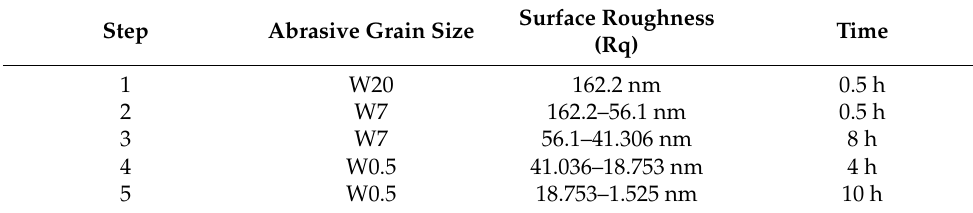
Figure 11. Surface morphology of initial surface, polished surface, and mirror surface: ( a ) Initial surface; ( b , c ) Polished surface; ( d ) Mirror surface. Table 3. Abrasive polishing process